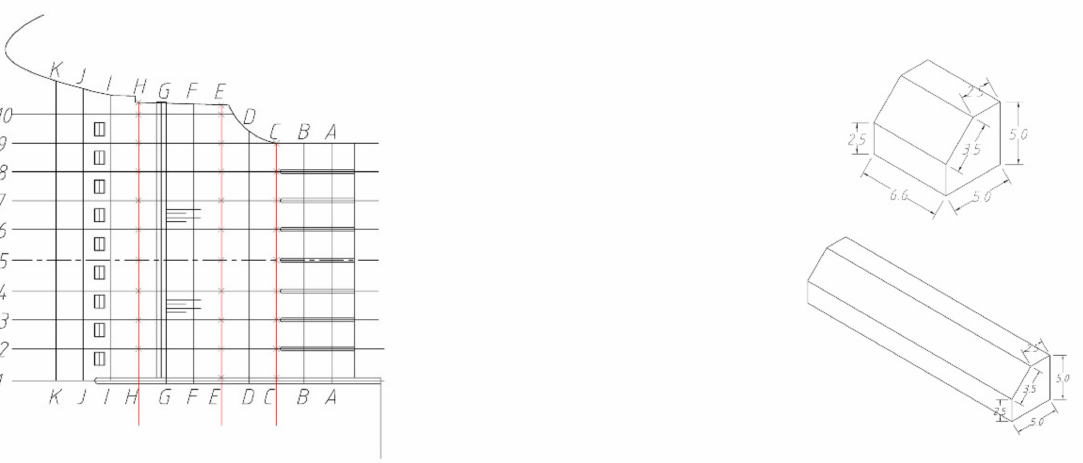
Figure 11. Plan 5 (unit: cm).